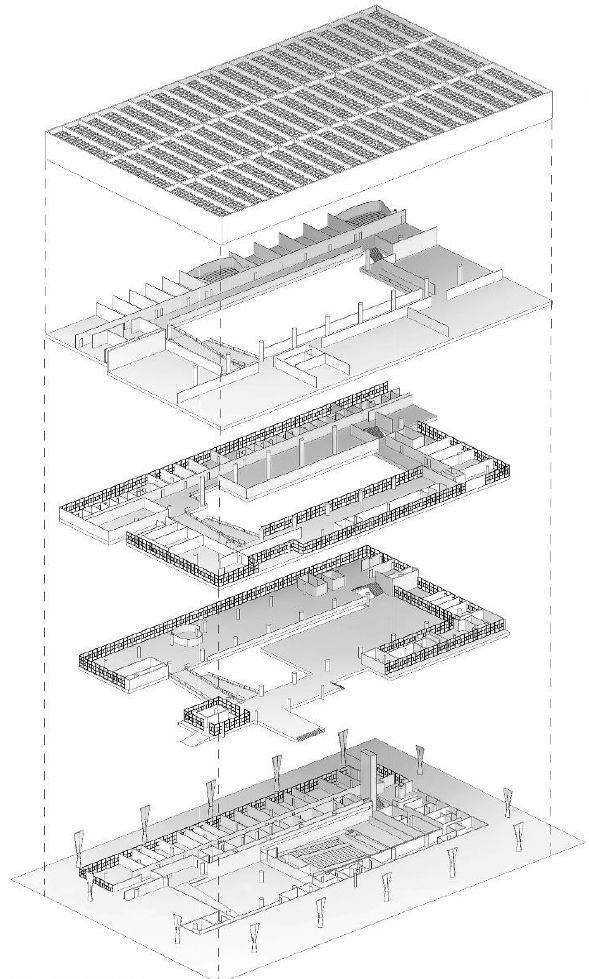
Figure 4. Villanova Artigas, FAUUSP (1953), Sao Paulo. Exploded axonometric